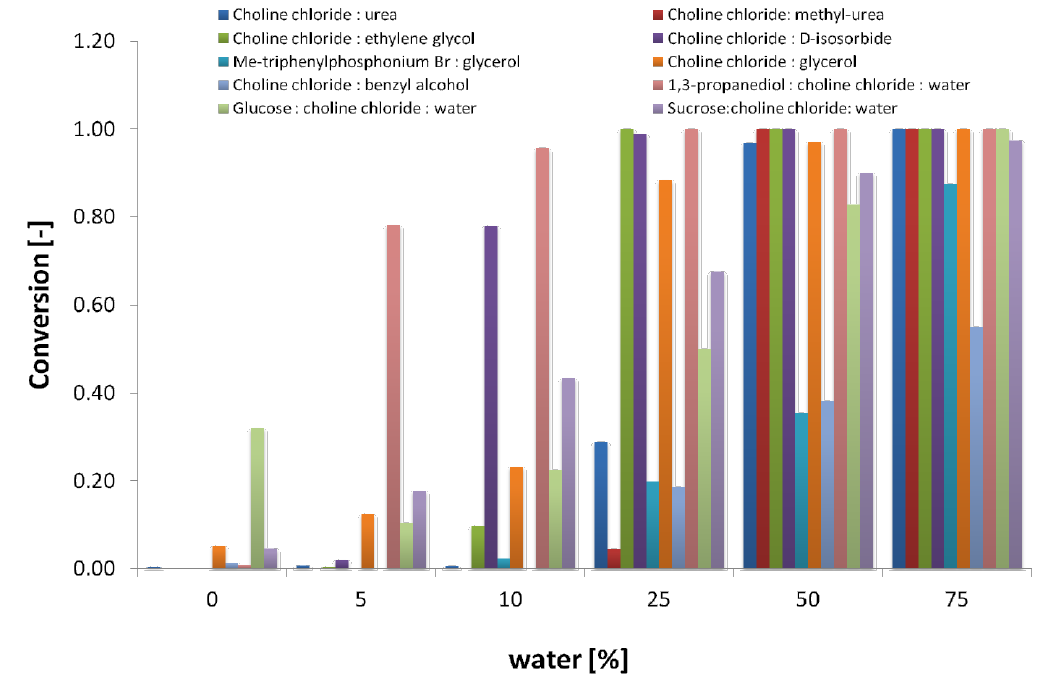
Figure 1. Effect of water content in water:DES cosolvent systems on maltotriose conversion in α - amylase-catalyzed hydrolysis reactions. No reaction was observed on choline chloride:malonic acid (1:1) and choline chloride:levulinic acid (1:2).